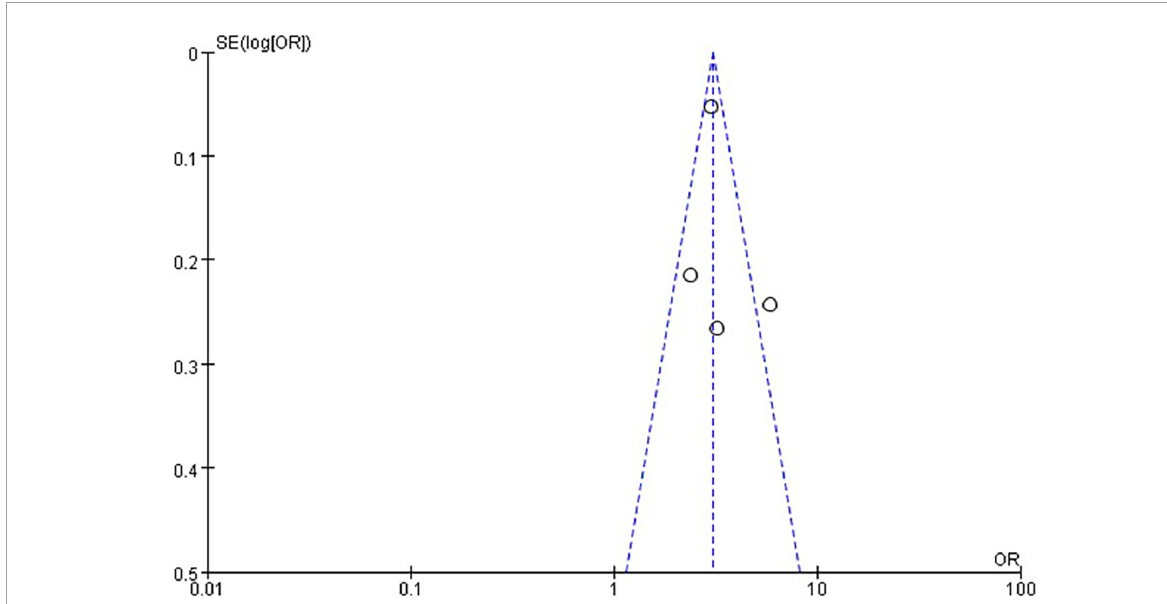
FIGURE3 Funnel plot with NAFLD and risk of low grip strength.